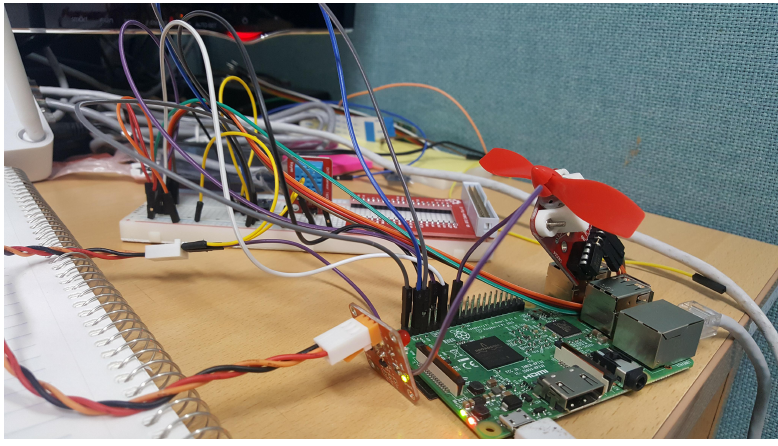
Figure 12. Implementation